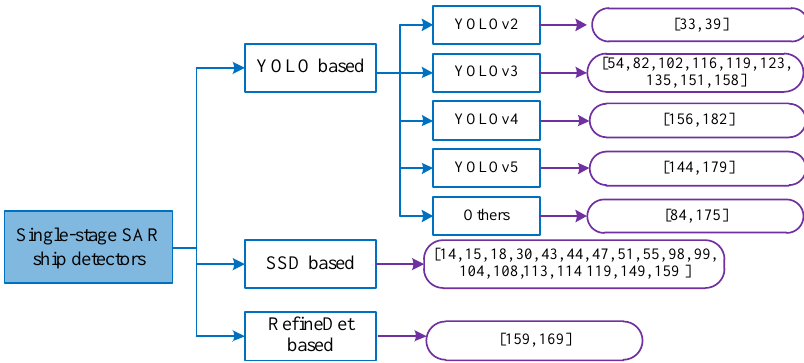
Figure 8. The single-stage SAR ship